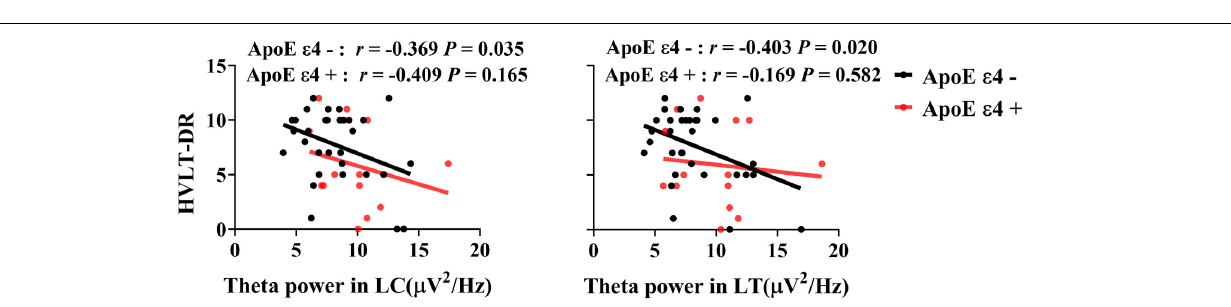
FIGURE 3 | Associations between the delayed recall performance and the theta power in the ApoE ε 4 non-carriers and carriers. There was a significant correlation between HVLT-DR scores and theta power in the left central and temporal regions in ApoE ε 4 non-carriers ( R LC = − 0.369, P LC = 0.035, R LT = − 0.404, P LT = 0.02, uncorrected), but not in ApoE ε 4 carriers. HVLT-DR, Hopkins Verbal Learning Test-Delayed Recall; LC, left central area; LT, left temporal